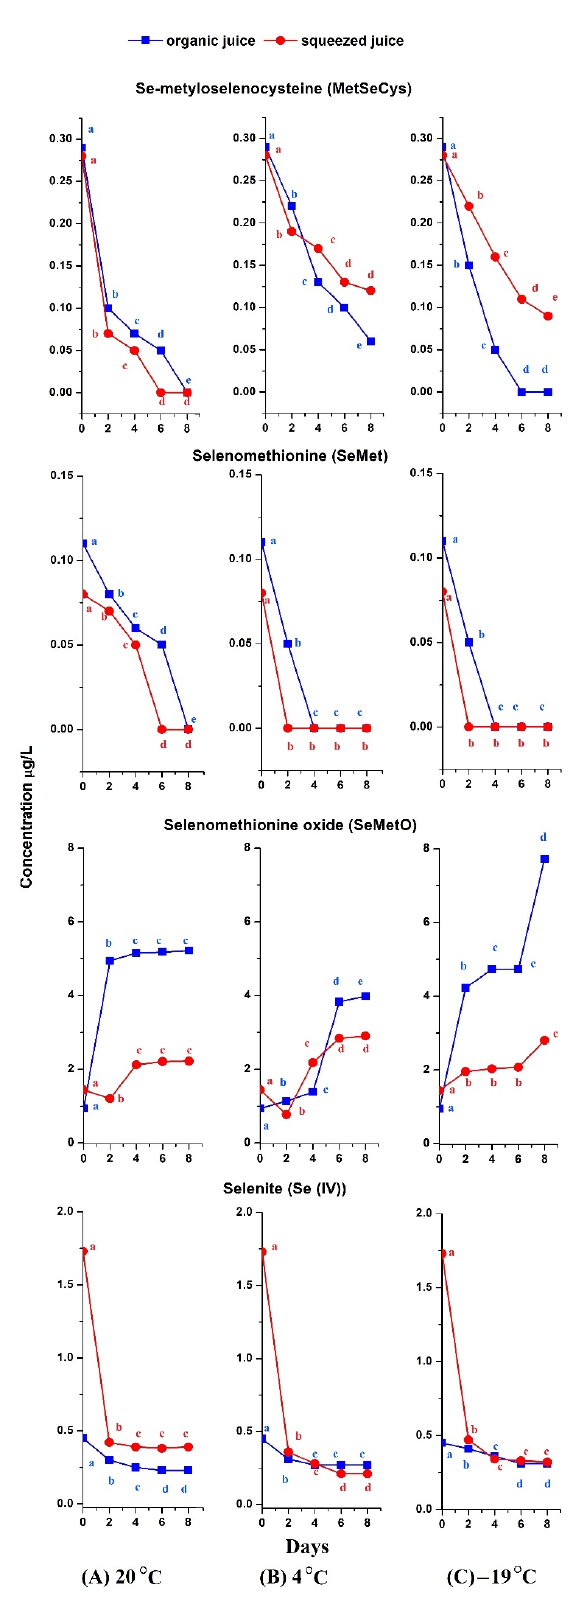
Figure 1. The changes in concentrations of selenium species in purchased organic and homemade squeezed beetroot juice without the addition of thiols stored at ( A ) 20 ◦ C, ( B ) 4 ◦ C, and ( C ) − 19 ◦ C as a function of storage time. Different letters in each point of the graph indicate a difference at a significance level of p = 0.05, showed a decrease in Se(IV) response after storage and that only 7% of this selenium form was present in the water extract after 4 days at 4 ◦ C